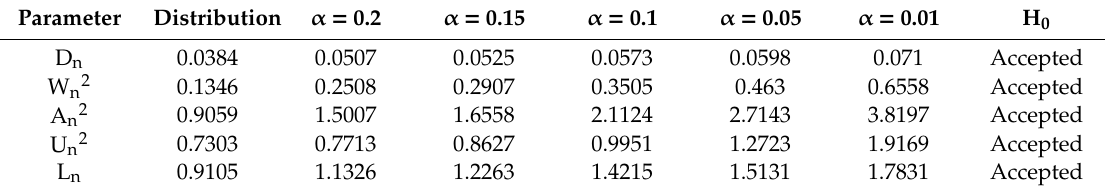
Table 2. The gamma distribution goodness-of-fit test for monthly rainfall data in the Rasht Basin.